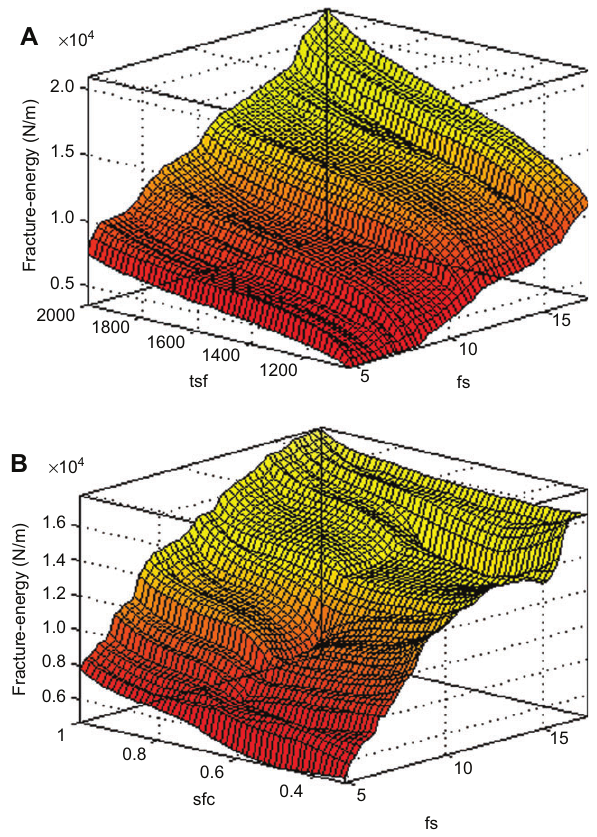
Figure 10 (A and B) The fracture energy from FL model as a function of inputs.